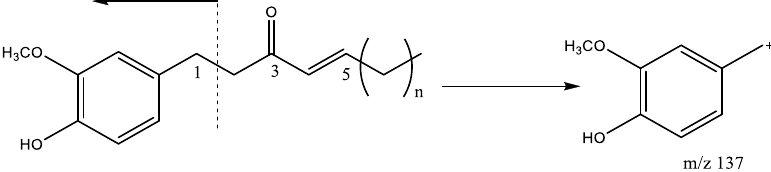
and 333.2430 (C 21 H 33 O 3 ) and were tentatively assigned to 6-shogaol, 8-shogaol and 10 shogaol, (Figure 5) [24]. ure 5) [24].